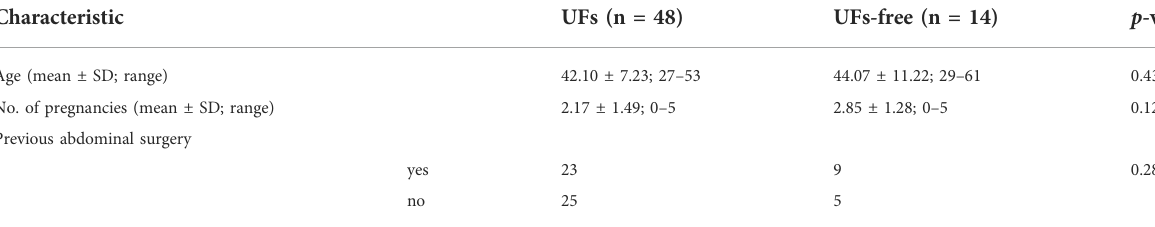
TABLE 3 Baseline characteristics of all participants.